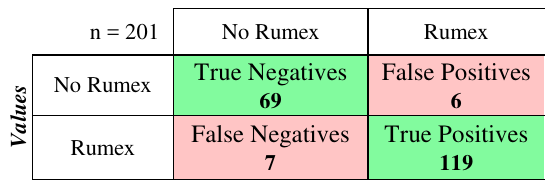
Figure 9: Confusion Matrix – Classification with 80% training data for basic